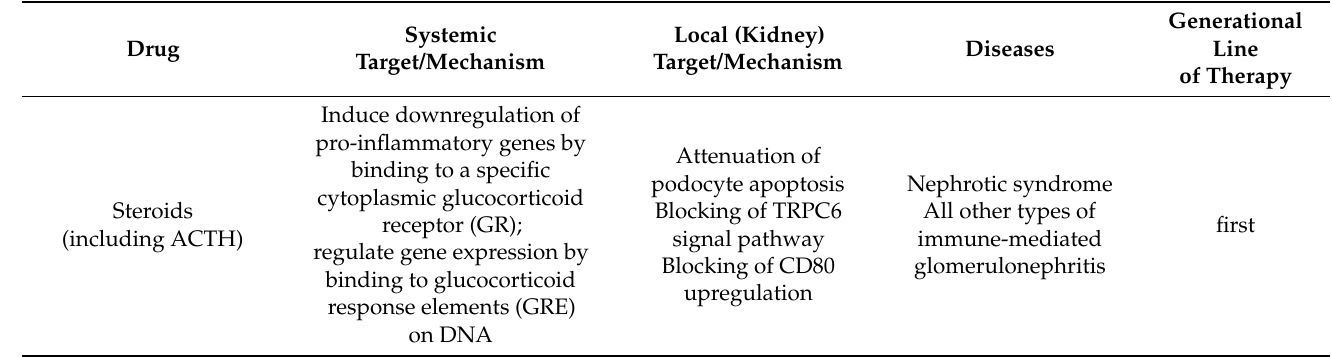
Table 1. Summary characteristics of the “classic” drugs used in pediatric immune-mediated kidney diseases [1–17].